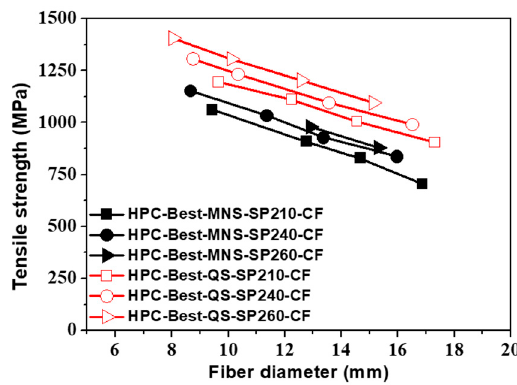
Figure 10. Tensile strengths of CFs obtained from HPC-MNS and HPC-QS derived pitches.